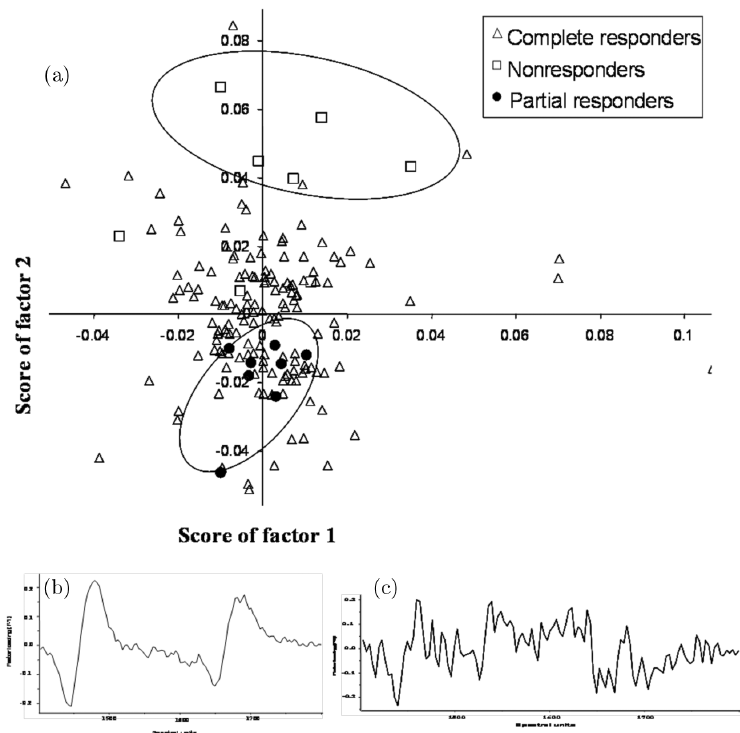
Fig. 4. PCA for complete, partial and nonresponder spectra. (a) Scatter plot of complete responders ( N ), nonresponders ( ) and partial responders ( (cid:4) ). (b) Loadings of factor 1. (c) Loadings of factor